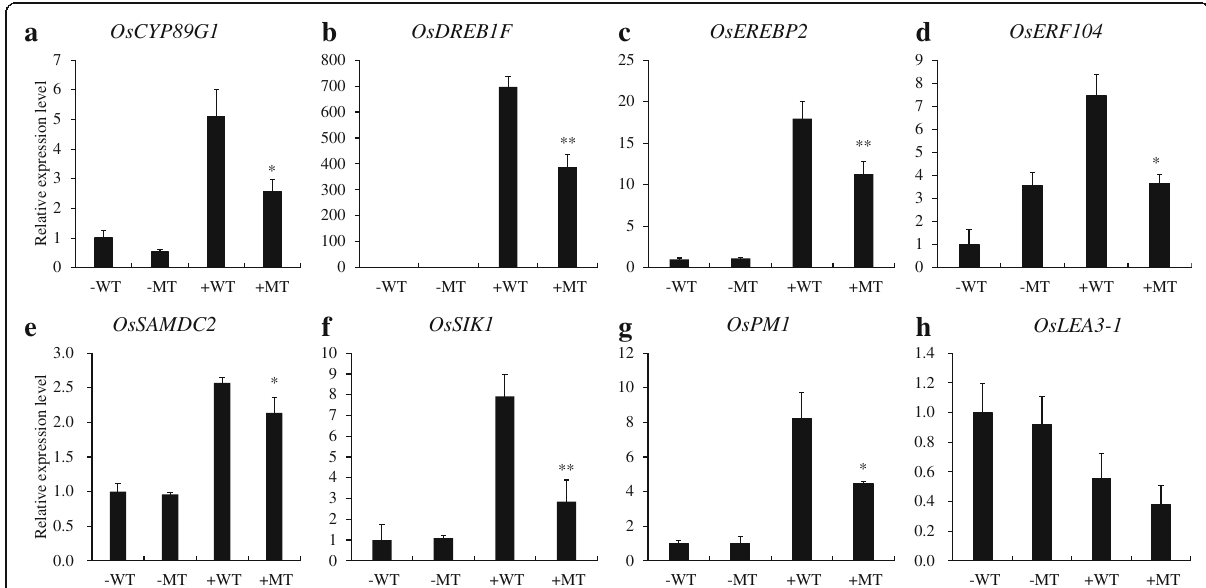
Fig. 8 Relative expression levels of eight possible DEGs in MT ( osnac45 -knockout) and WT (Nipponbare) roots under normal conditions and high salinity. OsCYP89G1 ( a ), OsDREB1F ( b ), OsEREBP2 ( c ), OsERF104 ( d ), OsSAMDC2 ( e ), OsSIK1 ( f ), OsPM1 ( g ), OsLEA3 – 1 ( h ). -WT and -MT indicate Nipponbare and OsNAC45 -knockout lines under control conditions. +WT and + MT represent Nipponbare and OsNAC45 -knockout lines treated with 100 mM NaCl for 24 h, respectively. Data are means ± SD of three biological replicates. * P < 0.05, ** P < 0.01 by Student ’ s t